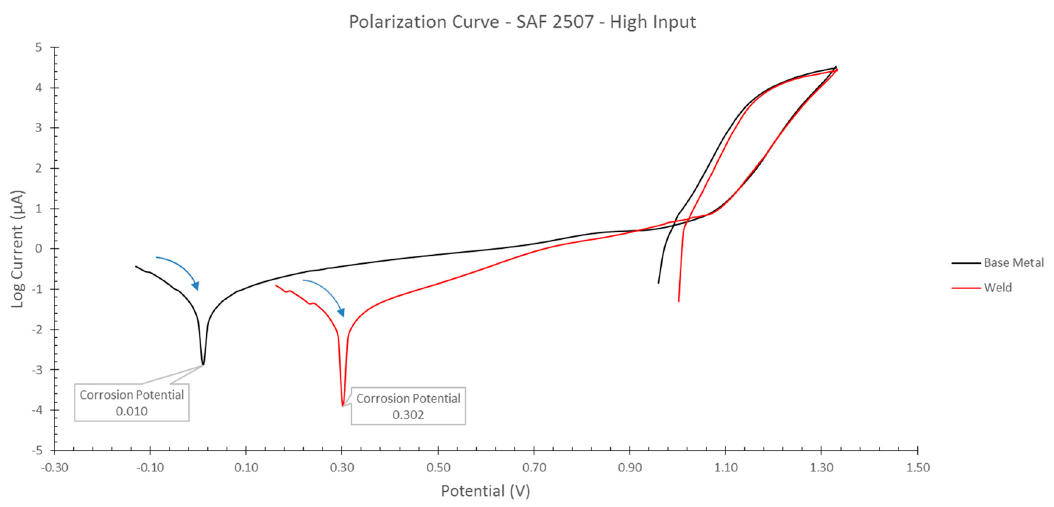
Figure 16. Polarization Curve—SAF 2507—High Heat Input. Base Metal and Weld region.